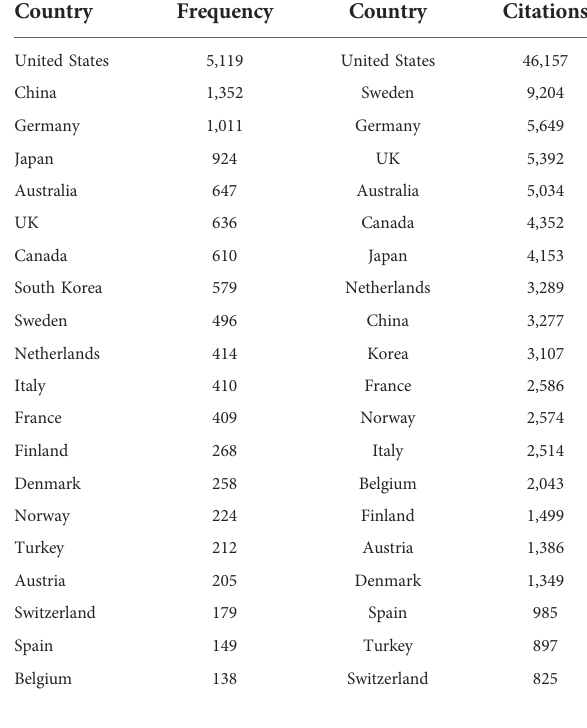
TABLE 4 Top 20 countries with the highest frequency in all authors and citations.